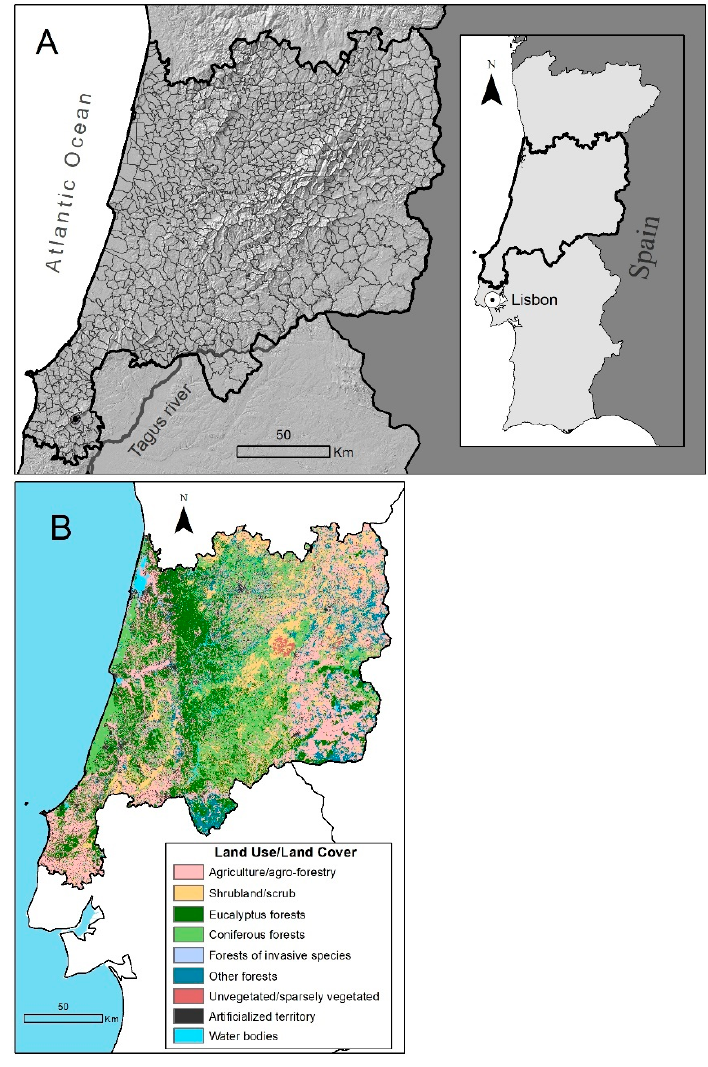
Figure 1. ( A ) Boundaries and position of the study area within mainland Portugal (NUTS II Centro ). Parish limits are also shown; ( B ) land use/land cover (2018), obtained from the 2018 Land Cover Map (Carta de Ocupação do Solo) produced by the General Directorate of the Territory (Direção-Geral do Território).